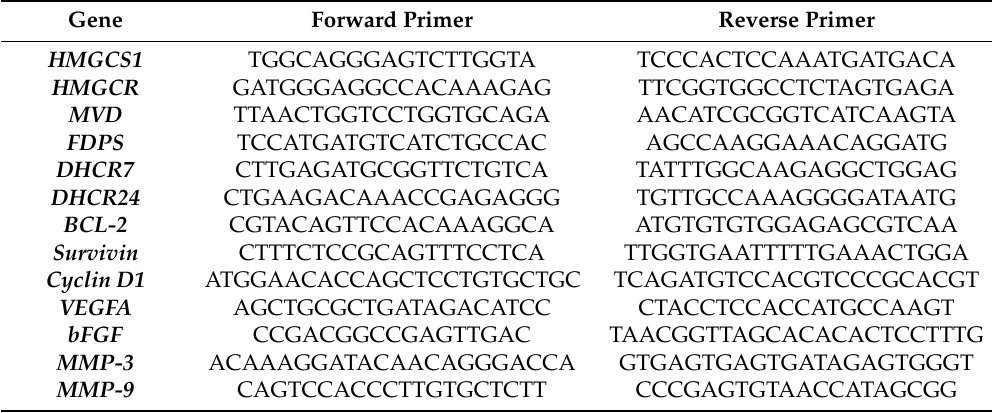
Table 1. Primer sequences for quantitative real-time